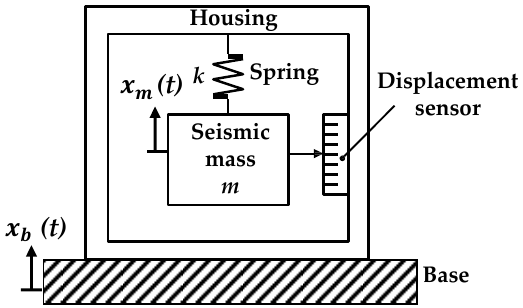
Figure 1. Typical accelerometer structure diagram.